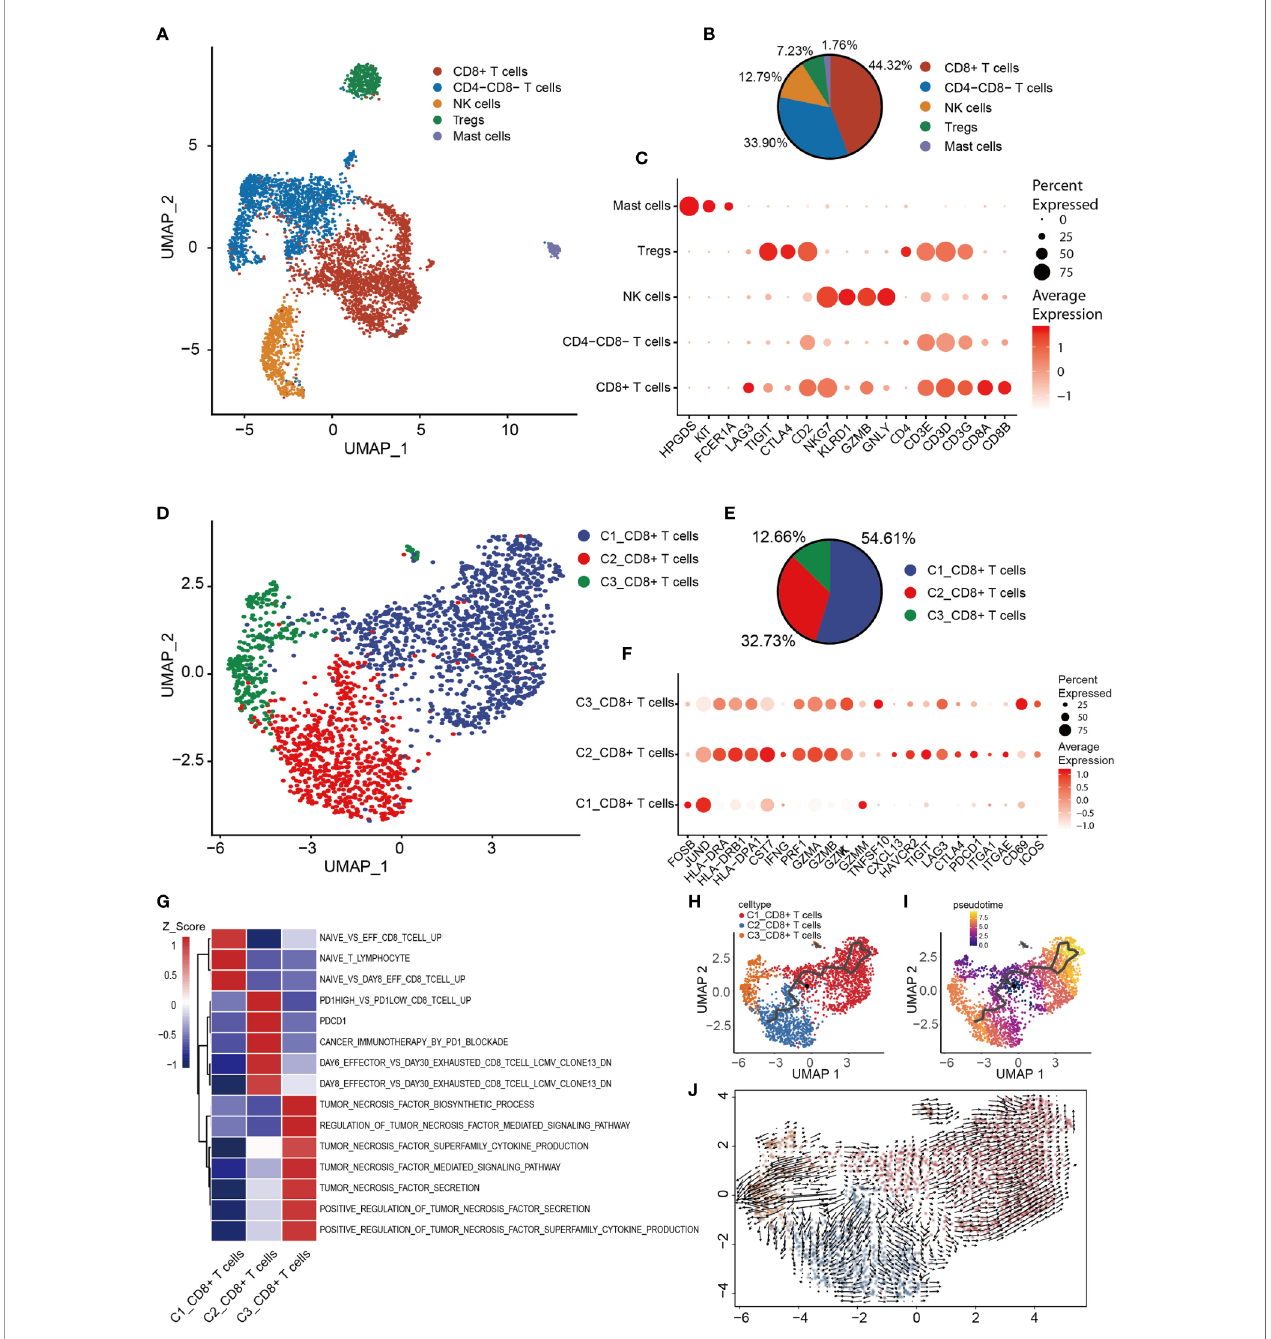
FIGURE 6 | Heterogeneity of NK/T cells populations in OS. (A) UMAP plot showing NK/T cells, with different cell types represented by the different colors. (B) Pie chart, showing the cell composition of NK/T cells, with different cell types represented by the different colors. (C) Dot-plot showing the marker genes in each cell subtype of NK/T cells; shades of red represent the expression level, and dot sizes represent the relative abundance. (D) UMAP plot representing CD8 + T cells, with different cell types represented by the different colors. (E) Pie chart showing the cell composition of CD8 + T cells, with different cell types represented by the different colors. (F) Dot-plot showing the marker genes in each cell subtype of CD8 + T cells; shades of red represent the expression level, and dot sizes represent the relative abundance. (G) GSVA, showing the function of the different subtypes of CD8 + T cells. (H, I) Differentiation and developmental trajectories of CD8 + T cells, with different colors representing different cell subtypes. (J) RNA velocity fi eld projected onto the UMAP plot of the CD8 + T cells; arrows indicate the direction of differentiation and average velocity. OS, osteosarcoma; UMAP, uniform manifold approximation and projection; GSVA, gene set variation analysis; NK, natural